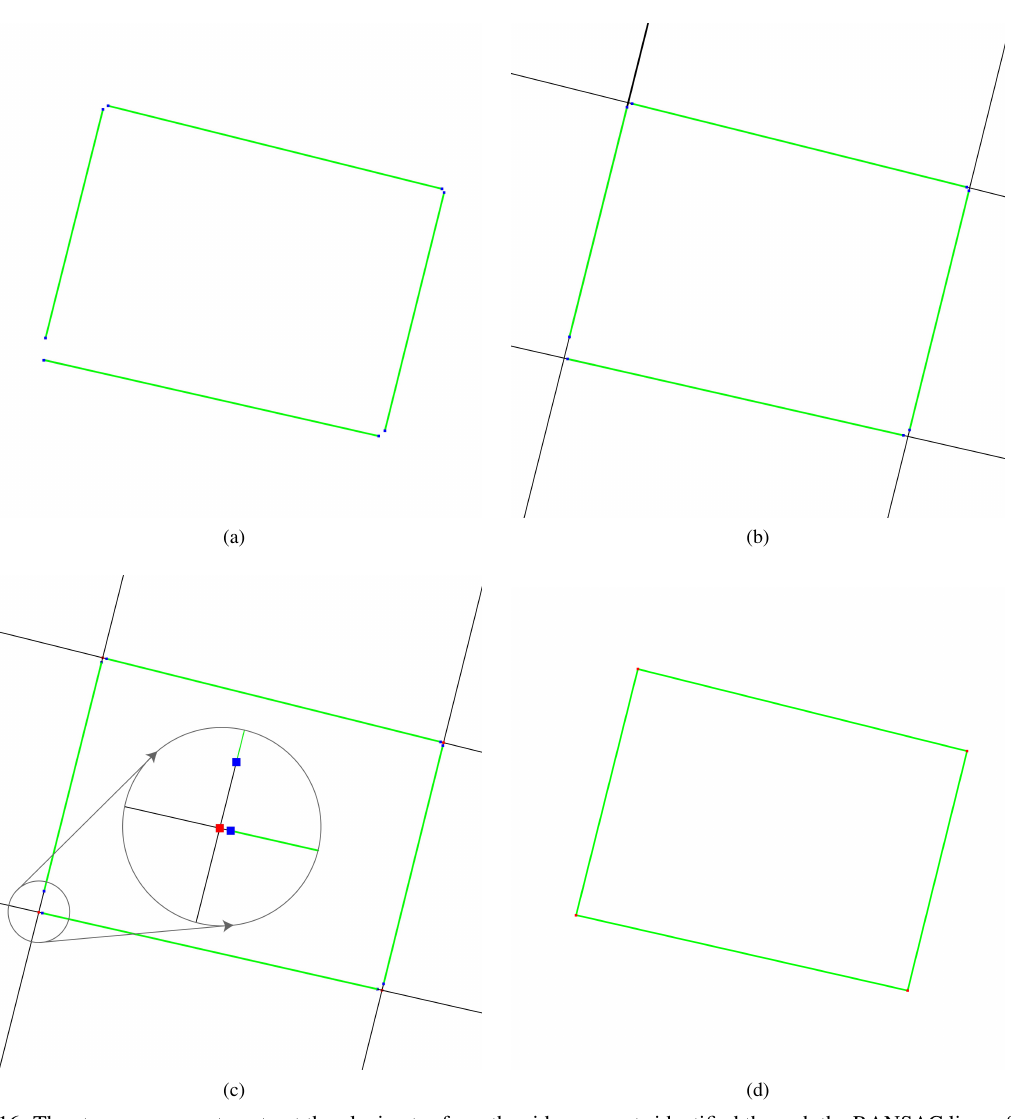
Figure 16: The steps necessary to extract the planimetry from the side segments identified through the RANSAC linear